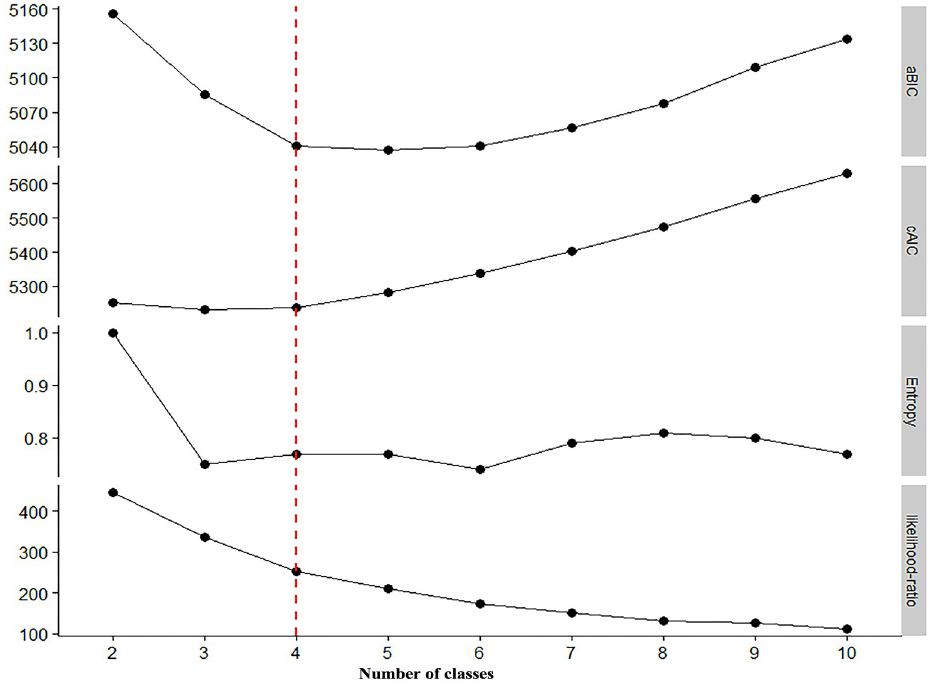
Fig 2. Number of latent categories screened via information